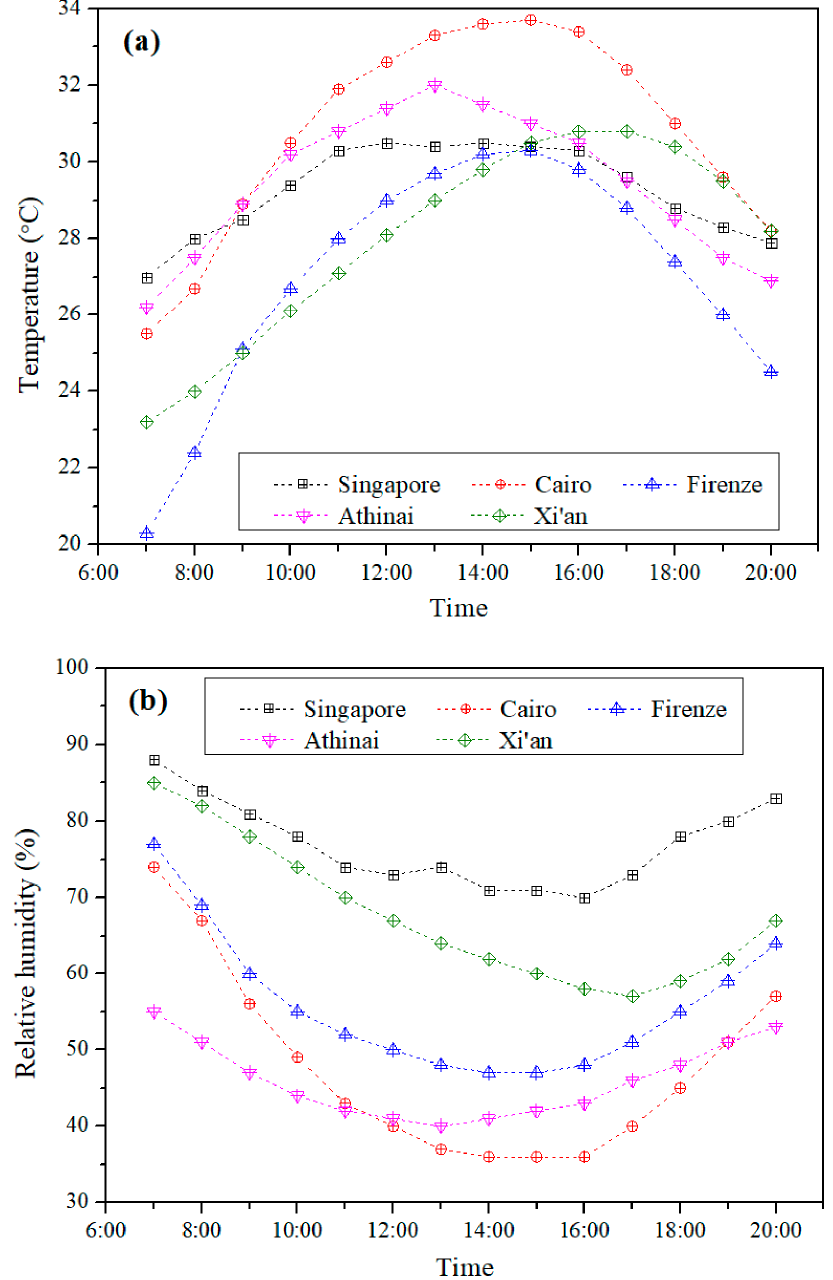
Figure 7. Average hourly statistics for ( a ) dry bulb temperature and ( b ) relative humidity in cooling months of various climates.